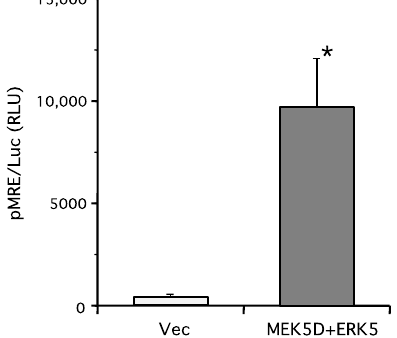
Figure 1. Overexpression of constitutively active mitogen-activated protein and extracellular signal-regulated (MAPK/ERK) kinase (MEK) 5 mutant and ERK5 causes activation of ERK5 signaling. Human embryonic kidney 293 cells (HEK293 cells) were transfected with tandem myocyte-enhancer factor (MEF) 2 response element (MRE)-luciferase reporter gene and empty vector (Vec) or MEK5D and ERK5. Two days after transfection, the luciferase activity resulting from MEF2 activation was measured. ERK5 significantly increased MEF2C activity (one experiment in triplicate ( n = 3), * p <0.05, unpaired Student’s t -test).